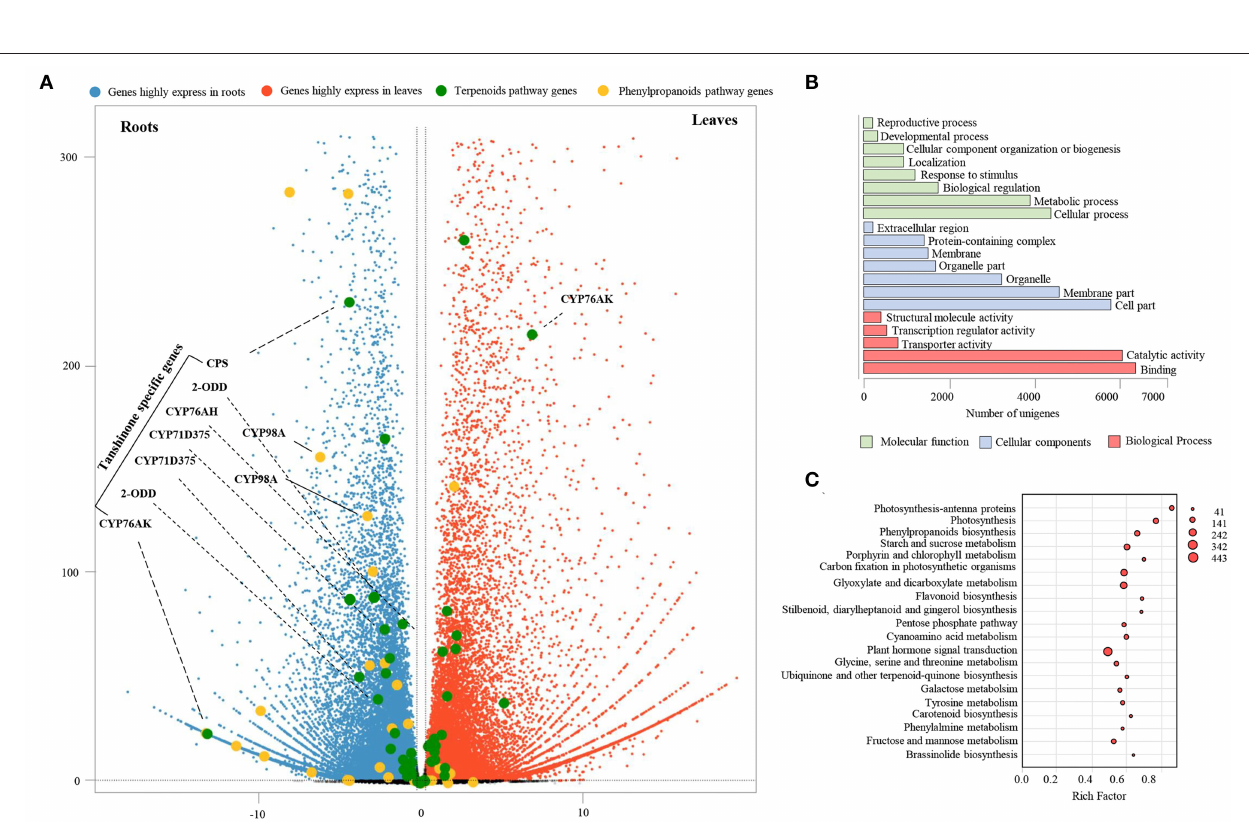
Frontiers in Plant Science |